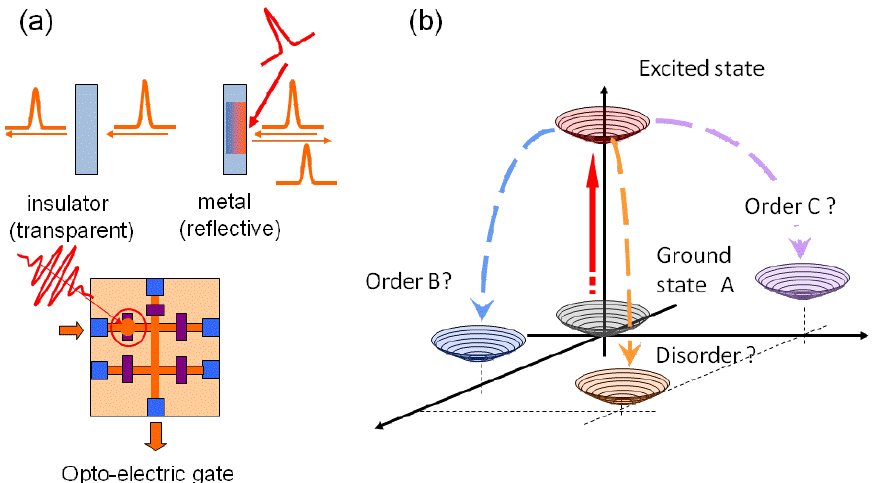
Figure 3. Schematic illustrations of ( a ) optical switch and ( b ) photoinduced phase transition from the ground state to non-equilibrium states on the free energy surface with multiple